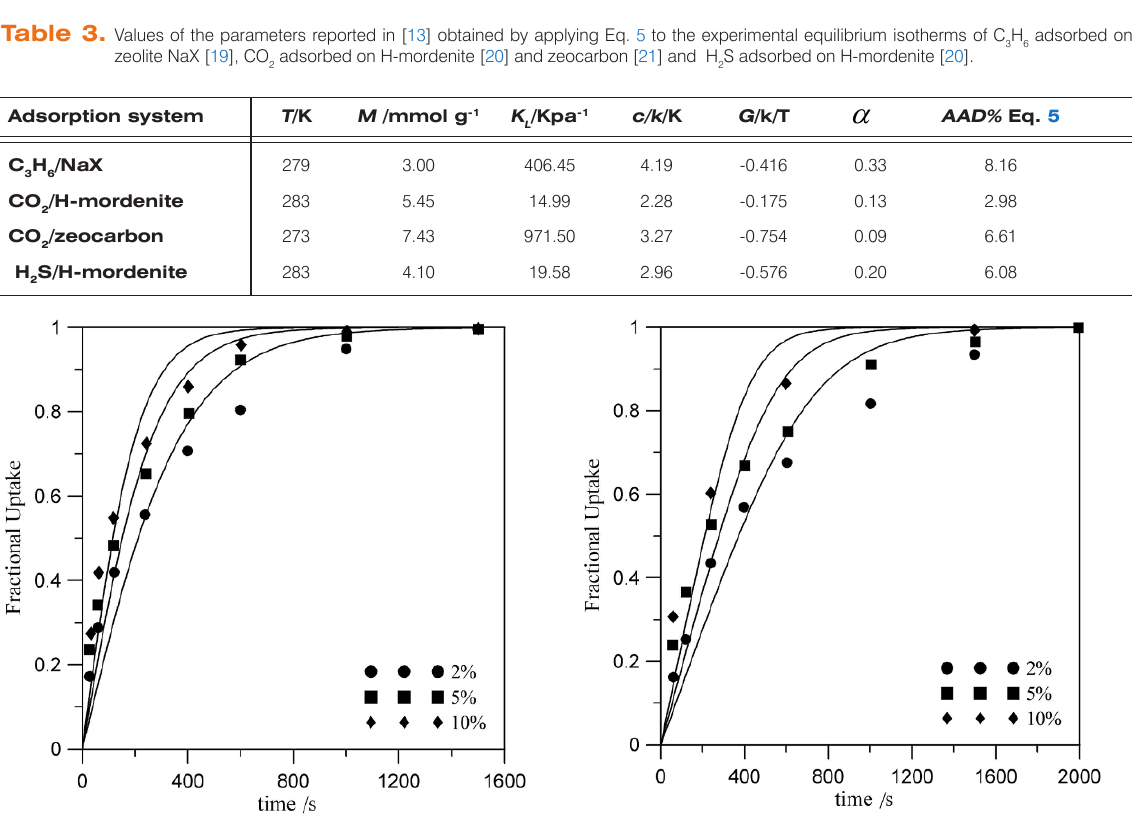
Table 2. Values of the parameters obtained by applying Eqs. 5 and 10 to the experimental equilibrium isotherms of C the Ajax activated carbon at 303 K [15]. The equilibrium parameter values have been reported elsewhere [13]. Bulk phase concentr.